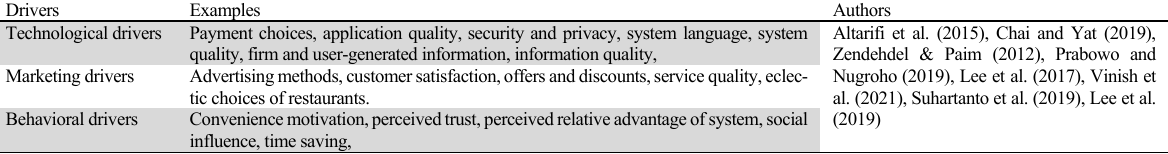
Drivers of online food delivery orientation in the literature Drivers Examples Authors Technological